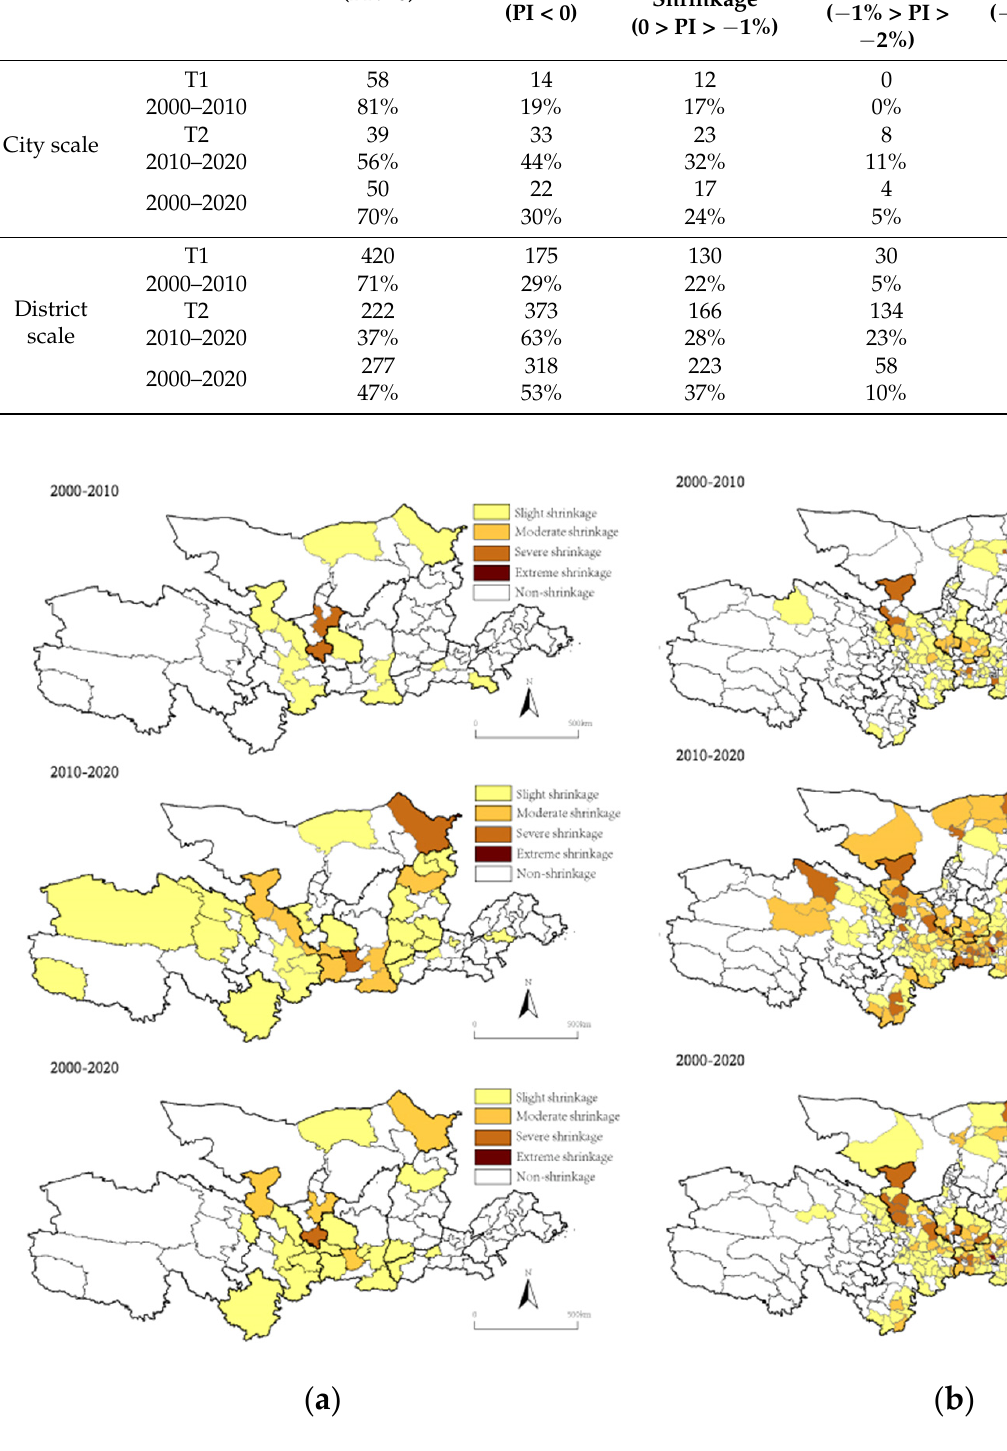
Figure 2. Shrinking patterns during different time spans in Yellow River Basin under the population dimension: ( a ) shrinkage patterns at city scale; ( b ) shrinkage patterns at district scale.